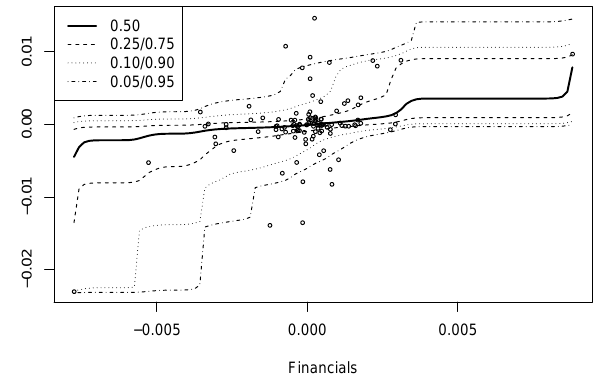
Figure 6. Estimated curves of regressing the differenced PDs of Utilities against the different PDs of Financial using linear quantile regression ( upper panel ), expectile regression ( middle panel ) and D-vine copula based quantile regression ( lower panel ) for different levels of α